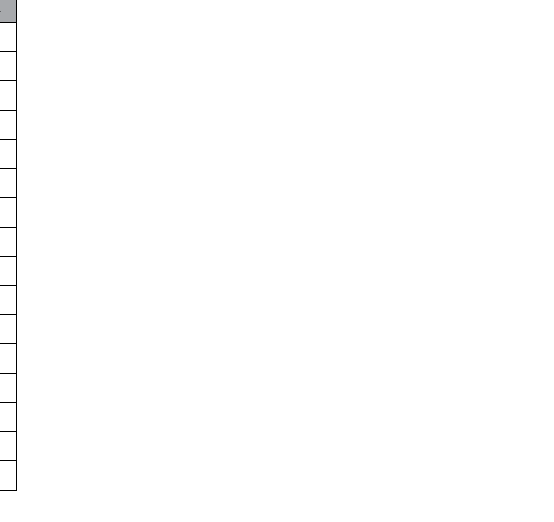
Table 4. Precursors